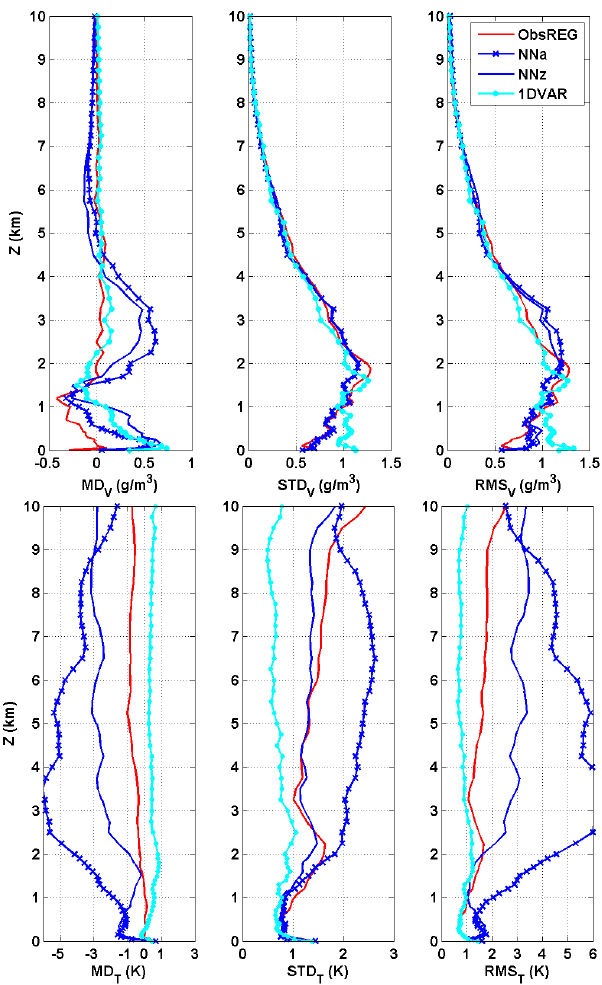
Figure 1. Statistics of water vapour density (top) and tempera- ture (bottom) profiles retrieved with NN, ObsREG, and 1-DVAR, as compared to radiosondes (233 cases). Left: mean difference (ra- diosonde minus retrievals). Centre: SD difference. Right: rms differ- ence. The legend in the top-right corner indicates the line color/style coding.